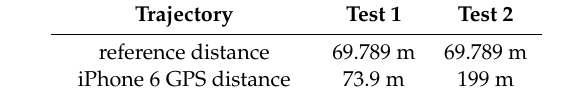
Figure 1. ( a ) First test; ( b ) Second test @ Google.